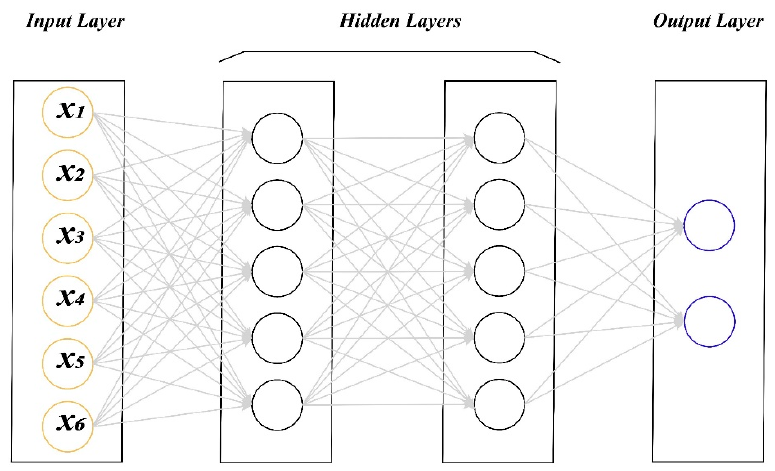
Figure A1. Graphical representation of an MLP model with two hidden layers.